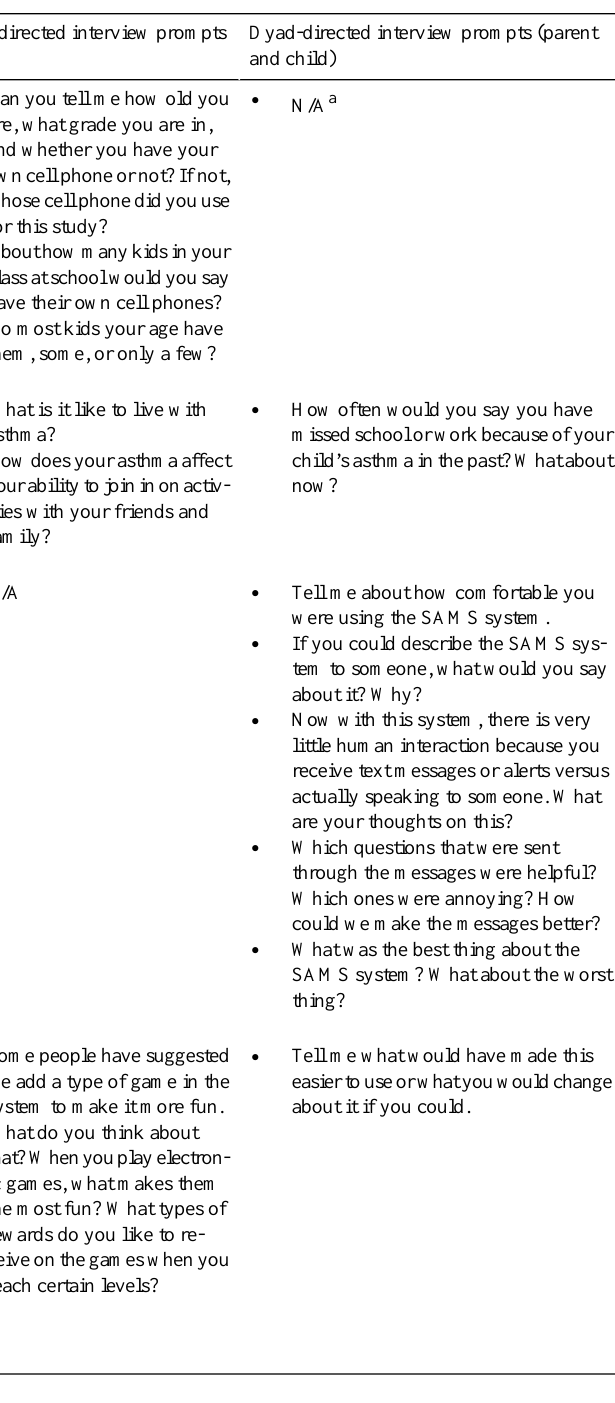
Table 1. Key informant interview guide.